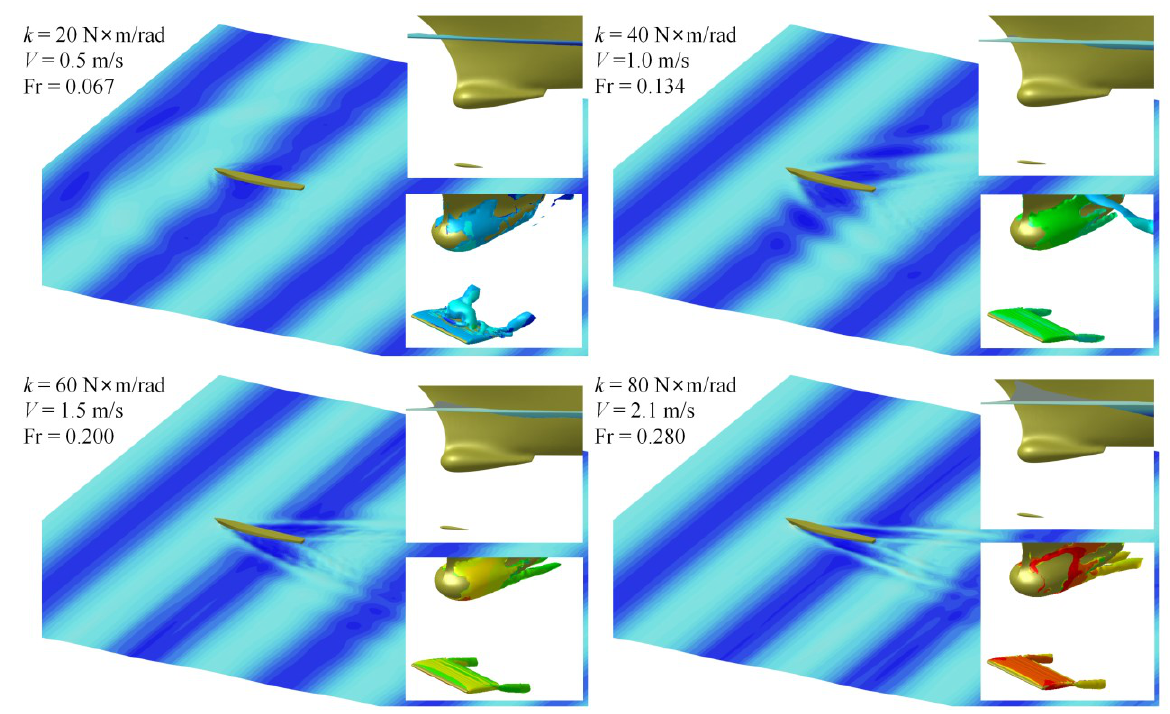
Figure 10. Simulation of the hull with self-pitching bow foil in head waves for different working